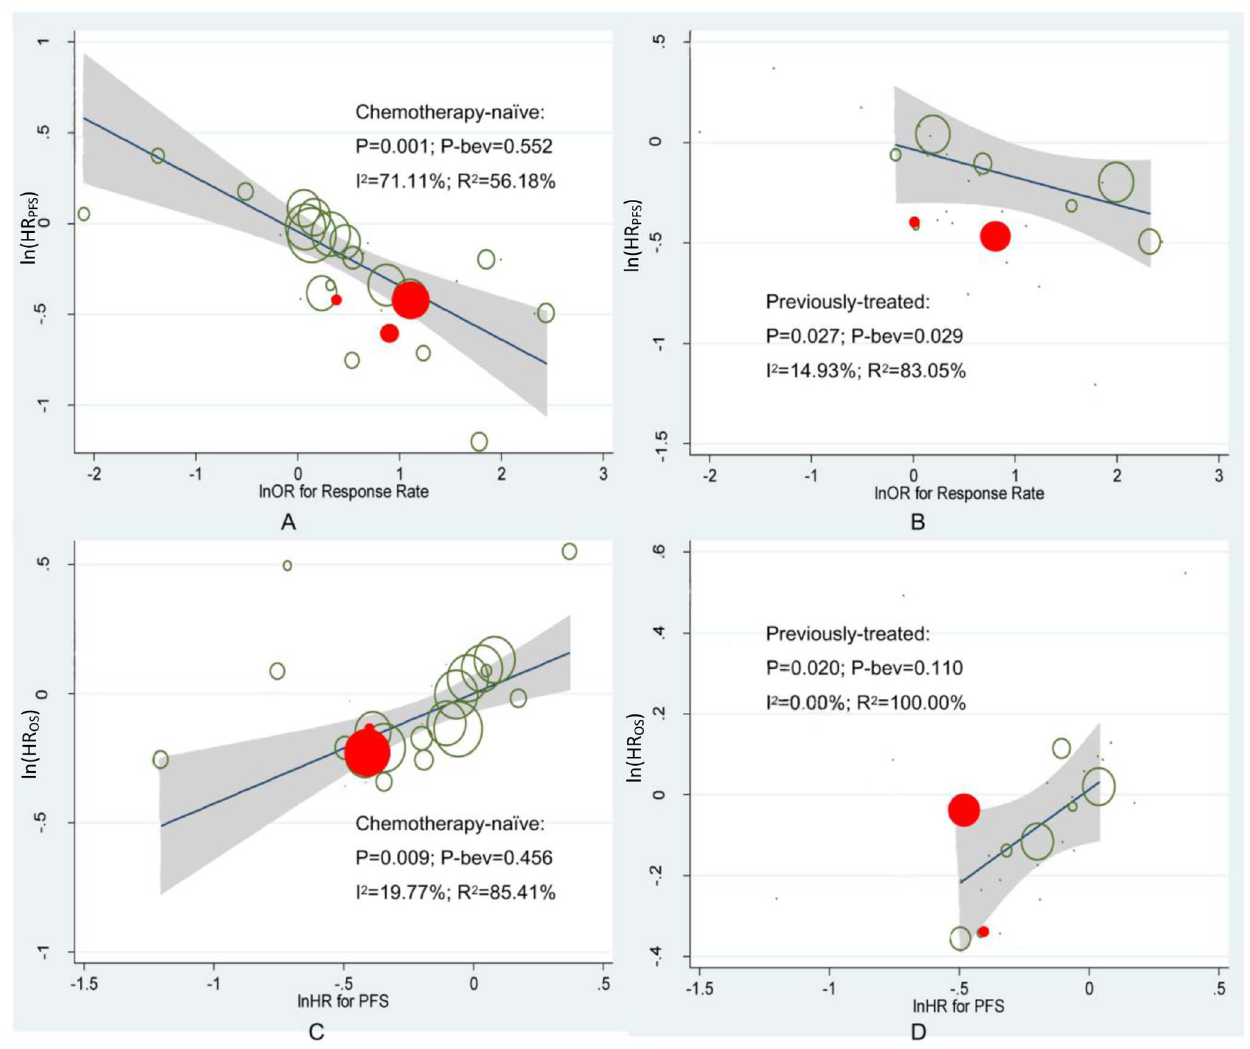
Figure 5. Results of meta-regression. A: ln(HR PFS ) – ln(OR ORR ), in chemotherapy-naı¨ve patients; B: ln(HR PFS ) – ln(OR ORR ), in previously-treated patients; C: ln(HR OS ) – ln(HR PFS ), in chemotherapy-naı¨ve patients; D: ln(HR OS ) – ln(HR PFS ), in previously-treated patients.